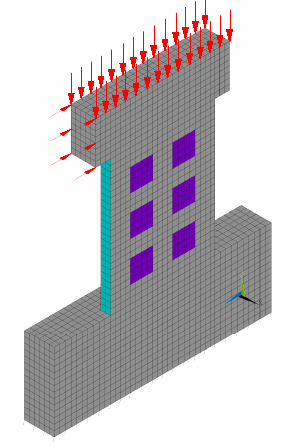
Figure 4. Typical FE mesh of the shear wall system. Grey, cyan, and purple colours represent concrete, and steel of columns and plates, respectively. Note that, for the sake of clarity, only half of the geometry has been shown